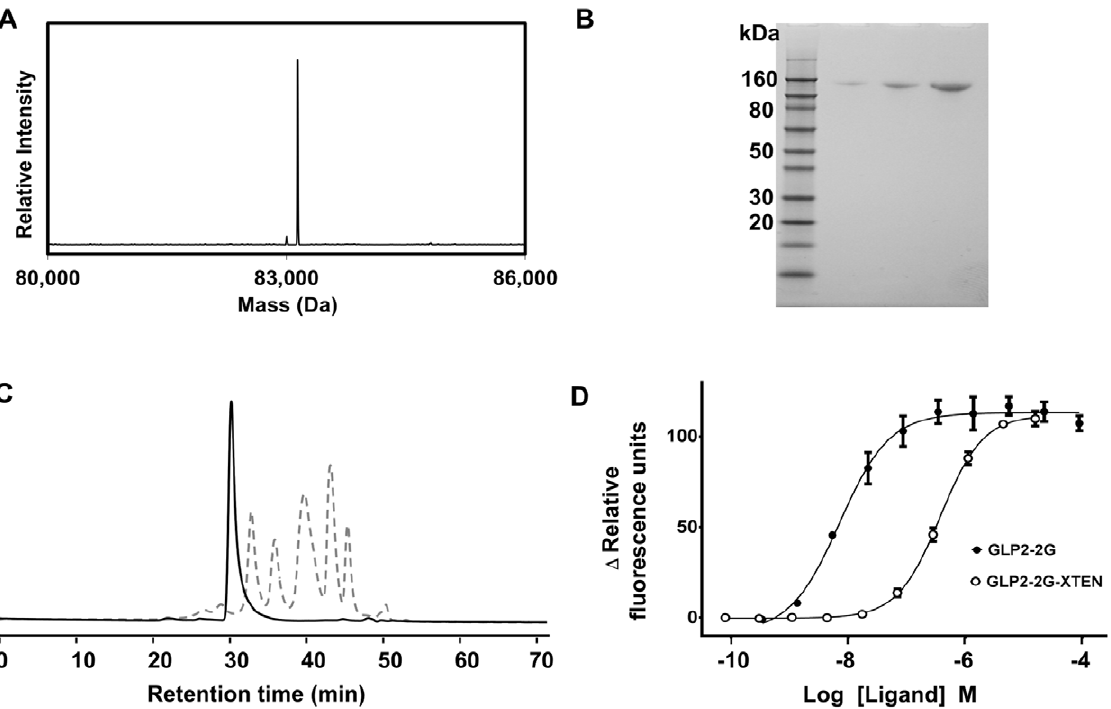
Figure 1. Invitro characterization of purified GLP2-2G-XTEN protein. A) ESI-MS analysis, major peak 83,142 Da – full length intact GLP2-2G- XTEN; minor peak 83,003 Da – des-His GLP2-2G-XTEN. B) non-reducing SDS-PAGE. Lane 1: molecular weight markers, lanes 2–4: 2 m g, 5 m g and 10 m g of GLP2-2G-XTEN, respectively. C) Size exclusion HPLC analysis. Solid curve: GLP2-2G-XTEN, 20 m g; dashed curve: molecular weights standard, which includes thyroglobulin 670 kDa, IgG 156 kDa, BSA 66 kDa, ovalbumin 45 kDa, myoglobin 17 kDa. D) Potency GPCR assay of GLP2-2G EC50=7 nM